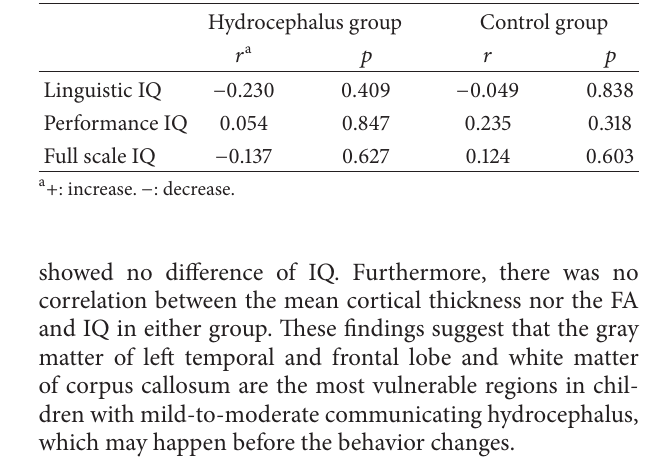
Table 6: Relationship between mean FA of the right corpus callosum body and